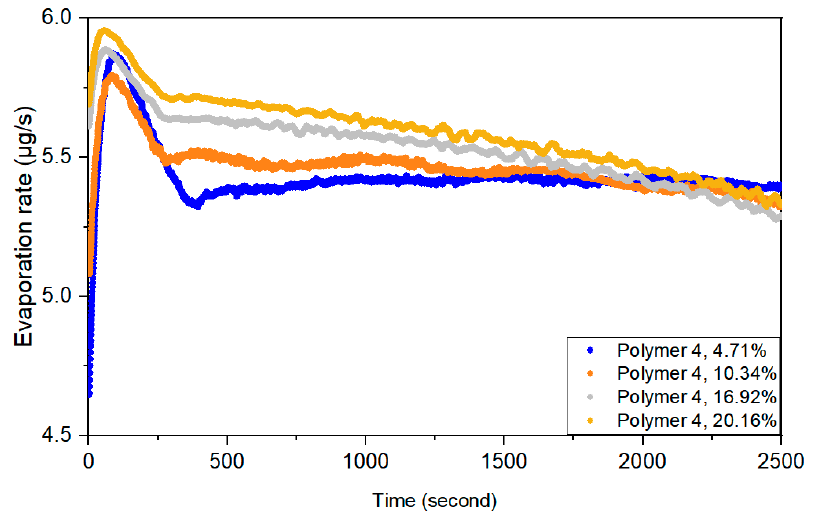
Figure 8. Evaporation rate of Polymer 4 solutions at 4.71%, 10.34%, 16.92% and 20.16% in the first 2500 s.